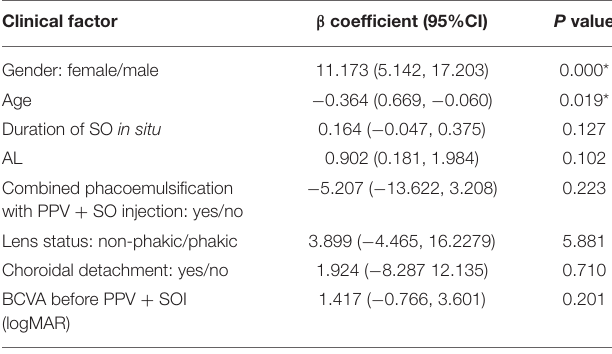
TABLE 2 | Results of multiple linear regression of factors associated with the total SO emulsification grade. Clinical factor